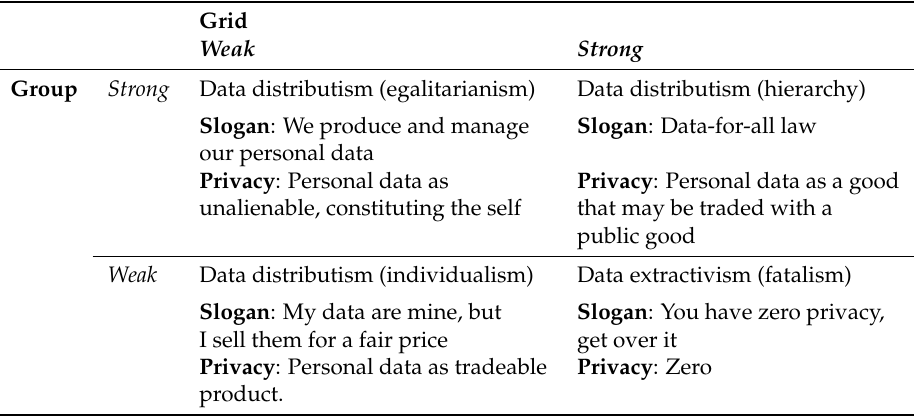
Table 4. A typology of privacy